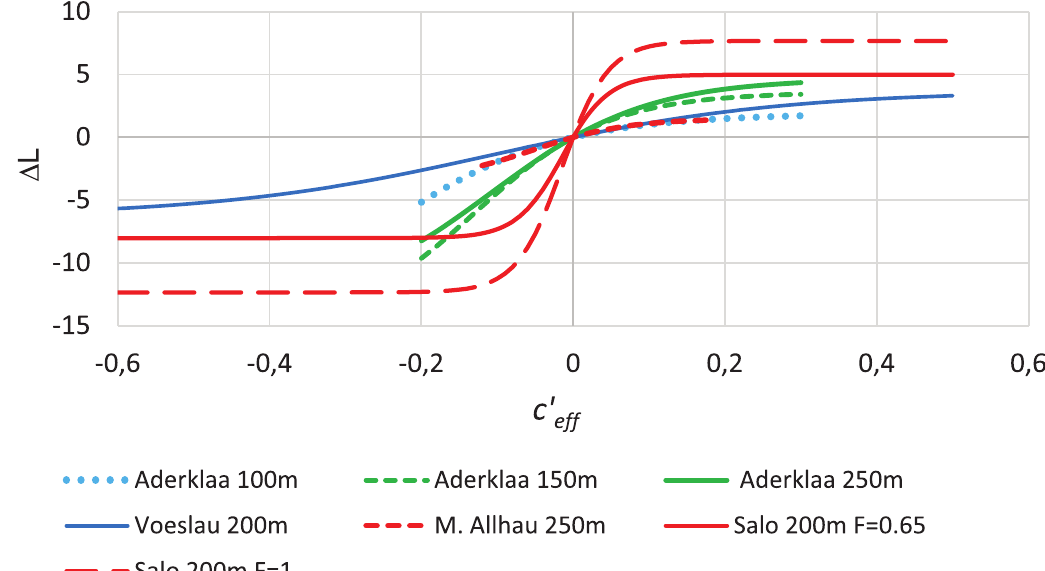
Figure 14. Sound level difference D L caused by the meteorological in fl uences versus the effective sound speed gradient for the different measurement situations in the range of 100 – 250 m distance in comparison with the calculations of Salomons and Bakri [10] mentioned as Salo. Table 3. Distance and height of the measurement points for calculation of factor F and the shift of the axis A . Geometrical parameters of